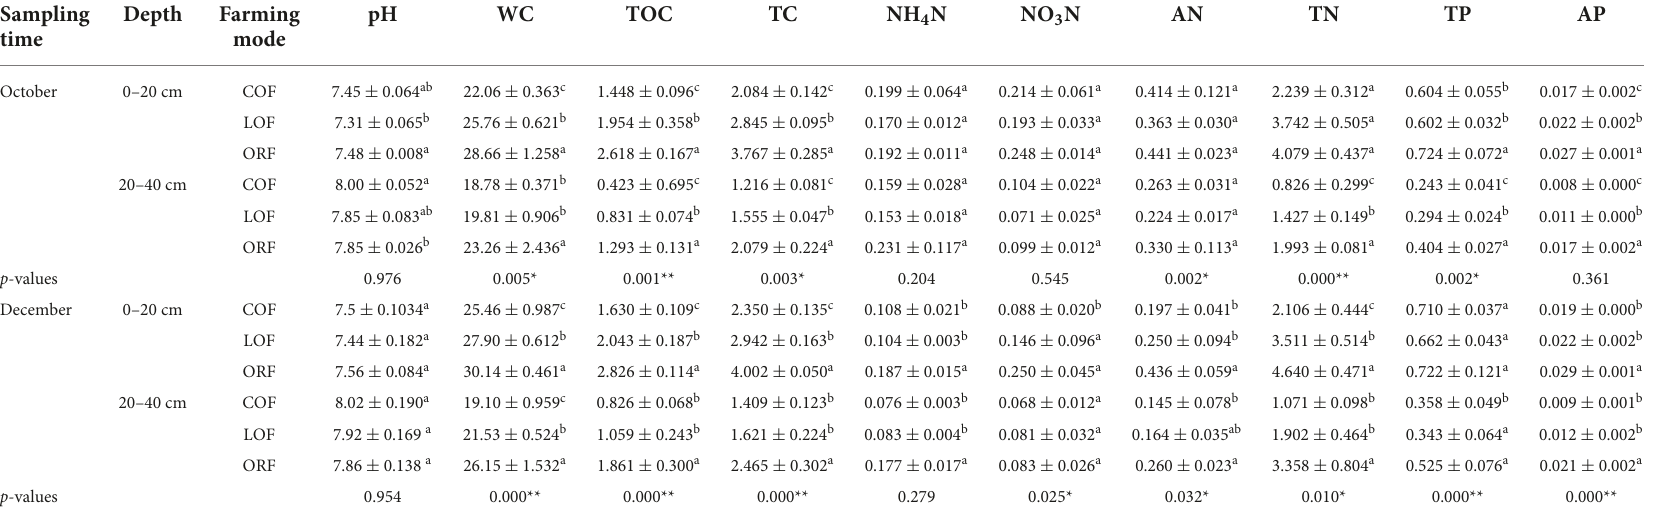
TABLE 1 Effect of different farming practices on soil parameters within different soil depths and sampling months. Sampling